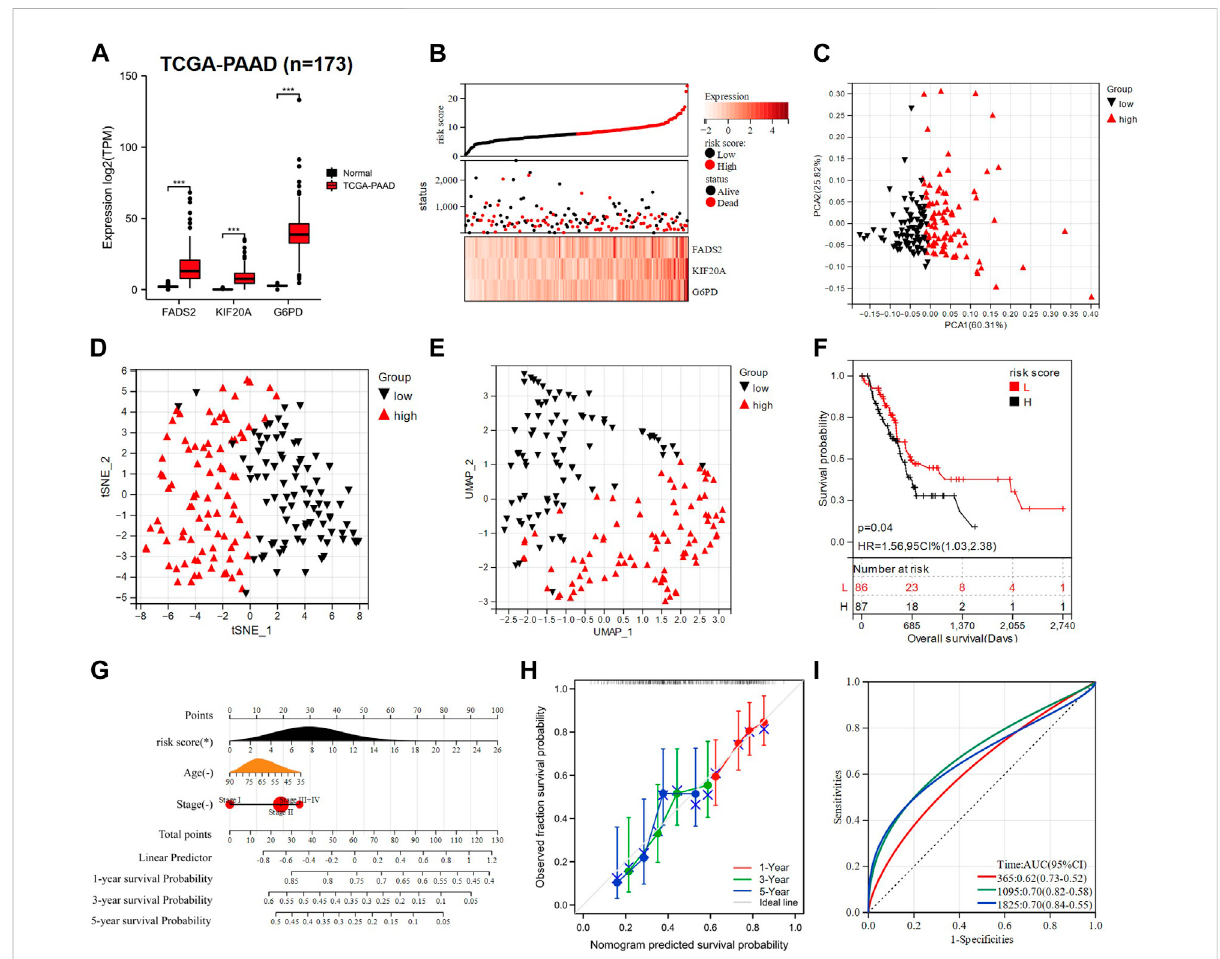
FIGURE 3 Construction of a PAAD prognostic model based on three candidate genes. (A) Comparison of the expression of three prognostic genes in normal( n =167)andPAADtissues( n =173). (B) TCGA-PAADpatientsweredividedintotwogroupsbasedonriskscores. (C – E) PCA,t-SNE,andUMAP analysis of TCGA-PAAD. (F) K-M analysis showed the OS of PAAD patients in the low- and high-risk groups. (G) A nomogram was constructed using risk score, age, and tumor stage. (H) The calibrationcurves for predicting PAAD patient OS at 1-, 3- and 5- year. (I) ROC analysisof 1-, 3- and 5- year OS in PAAD patients. PAAD: Pancreatic adenocarcinoma; TCGA: The Cancer Genome Atlas; PCA: principal component analysis; t-SNE: t-distributed Stochastic Neighbor Embedding; UMAP: uniform manifold approximation and projection; K-M analysis: Kaplan-Meier analysis; OS: overall survival; CI: combination index; ROC: receiver operating characteristic; AUC: area under the curve; HR: hazard ratio. * p < 0.05; ** p < 0.01; *** p < 0.001; **** p < 0.0001; ns p >